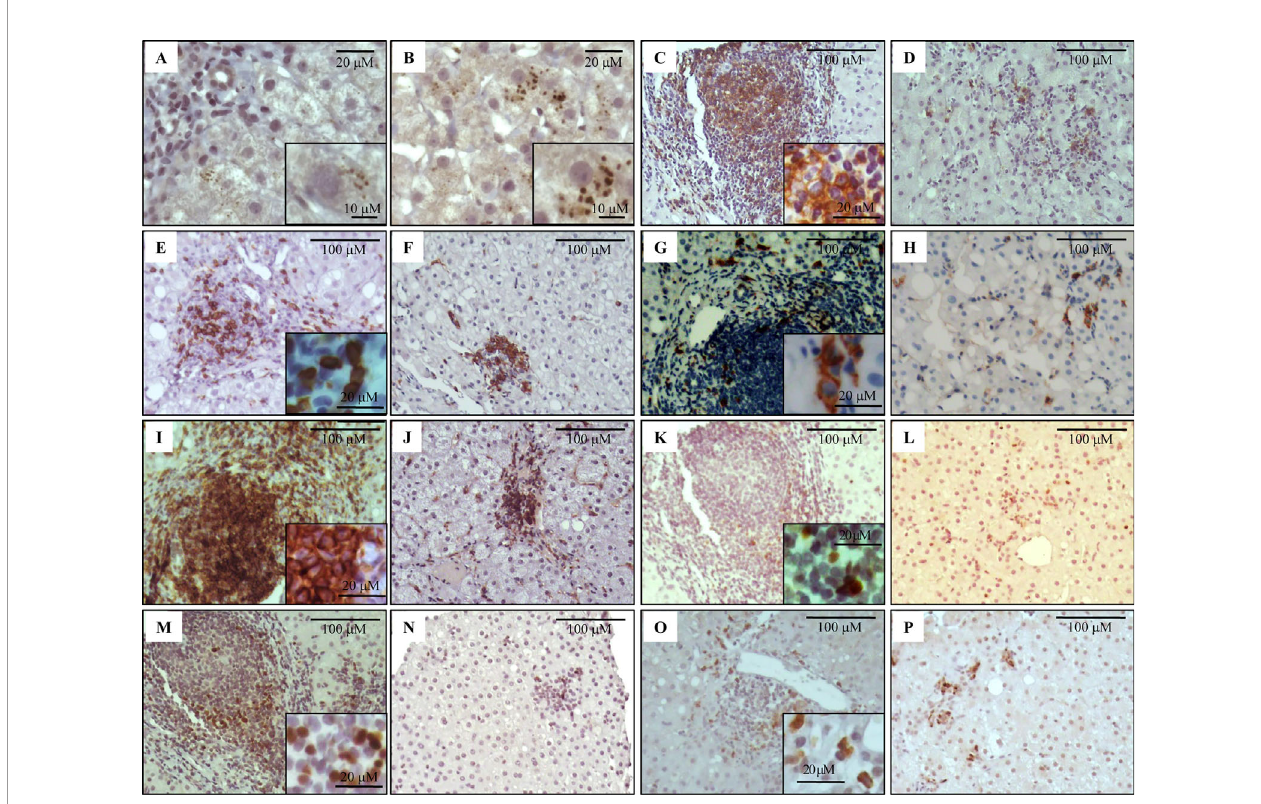
FIGURE 1 | Immunostaining of NS3 and liver in fi ltrating lymphocyte populations on formalin- fi xed paraf fi n embedded liver biopsies. Representative images of NS3+ hepatocytes (A, B) , CD20+ (C, D) , CD8+ (E, F) , CD56+ (G, H) , CD4+ (I, J) , Tbet+ (K, L) , Foxp3+ (M, N) and IL-17A+ (O, P) lymphocytes. Portal – periportal tract (A, C, E, G, I, K, M, O) and lobular area (B, D, F, H, J, L, N, P) .